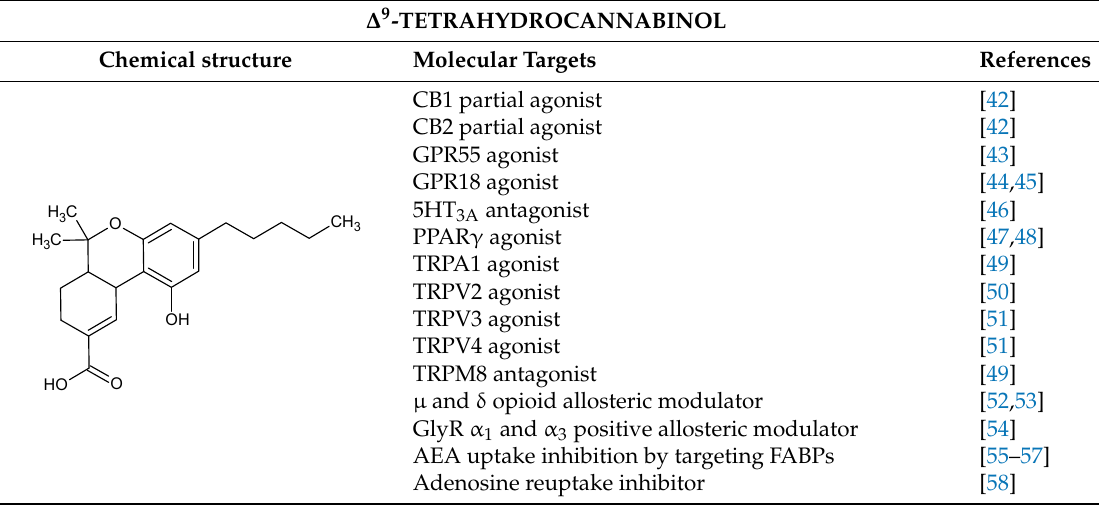
Table 2. Molecular targets of the most abundant phytocannabinoids in Cannabis sativa .